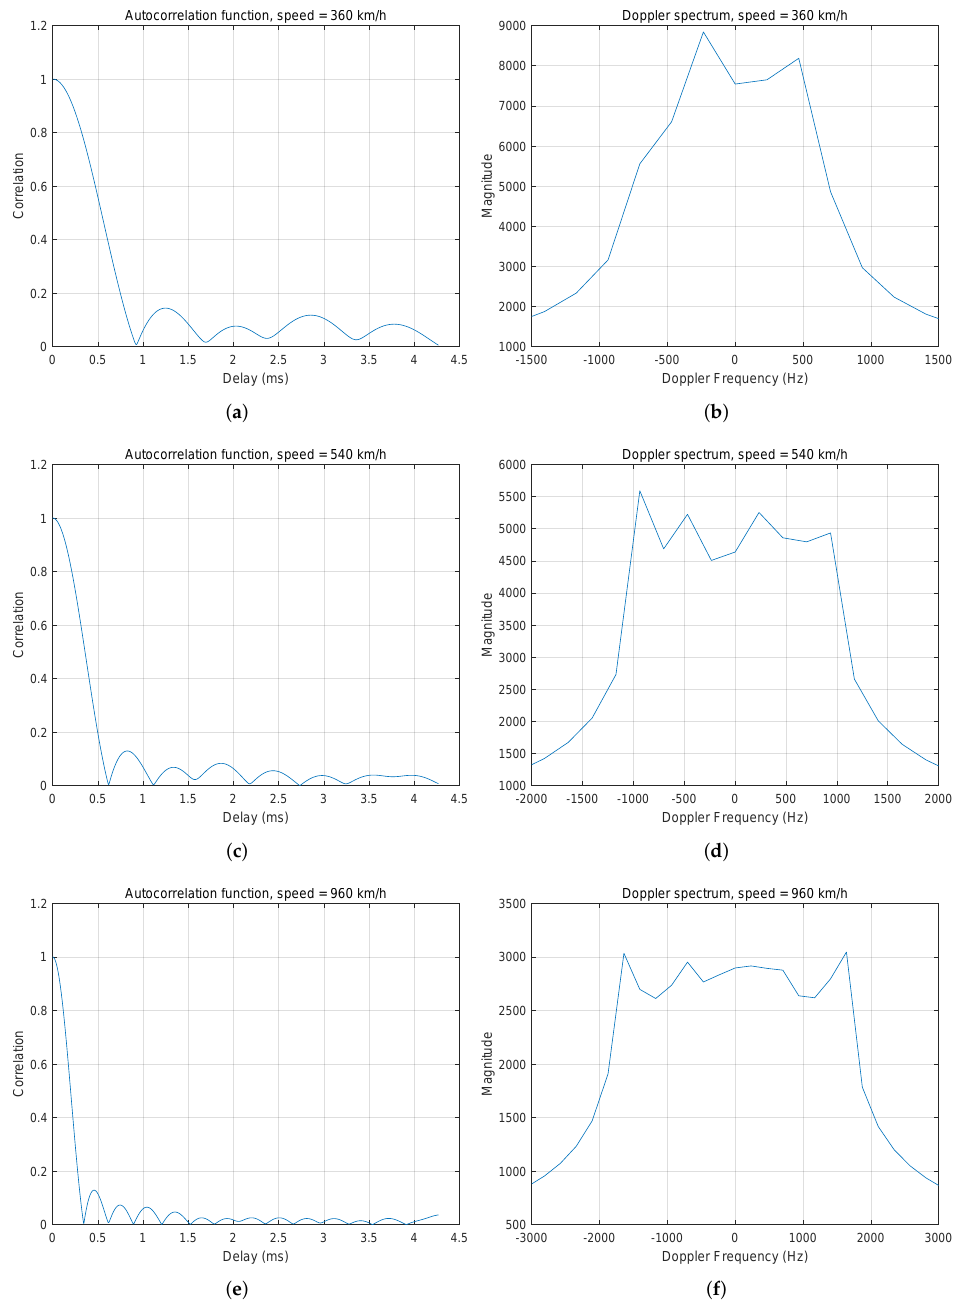
Figure 4. The autocorrelation function and the Doppler spectrum for the LOS component: ( a , b ) v = 360 km/h; ( c , d ) v = 540 km/h; ( e , f ) v = 960